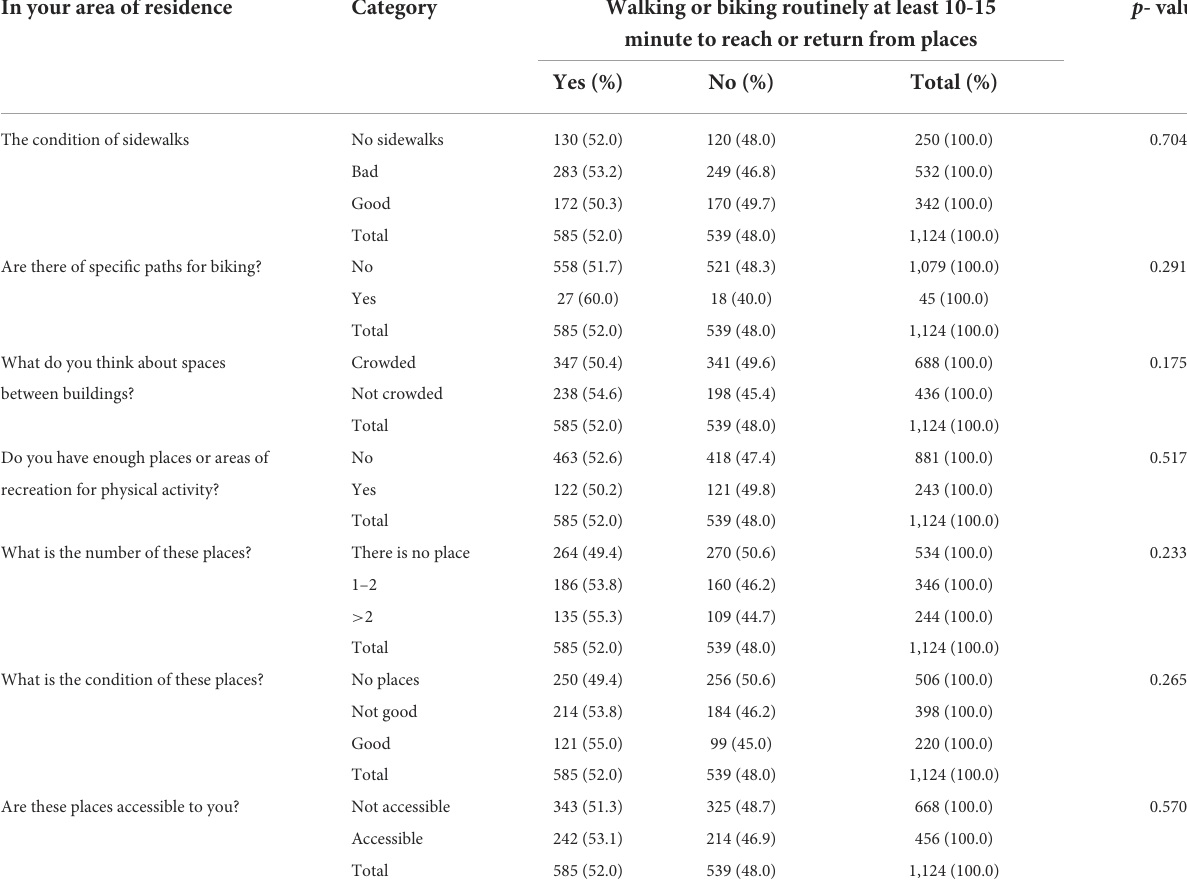
TABLE 5 Distribution of perceptions about built environment by walking or biking practices of study participants ( N =